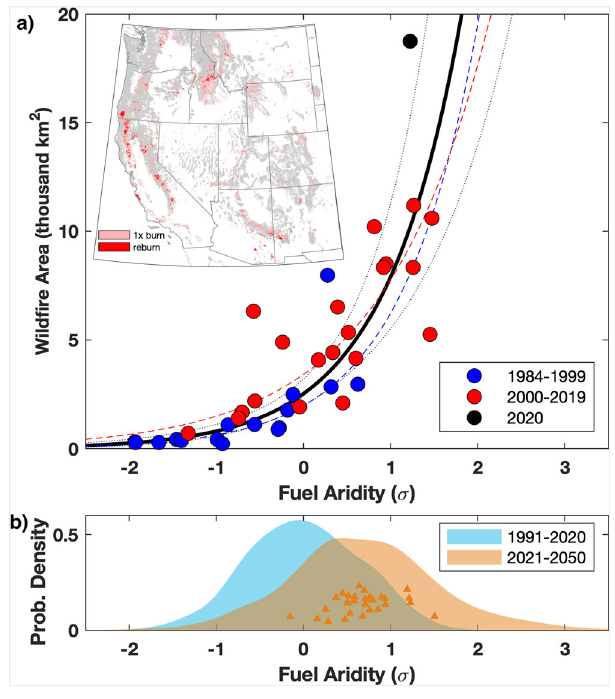
Fig. 1 Nonlinear climate – fi re relationships in western US forests. a Interannual relationship between fuel aridity ( F ) over forested lands vs. annual forest- fi re area for the western US. Curves represent regression for the period 1984 – 2020 (black, dotted shows 95th percentile con fi dence interval), 1984 – 1999 (dashed blue), and 2000 – 2020 (dashed red). Inset map shows forested land burned once (pink) and more than once (red) during 1984 – 2020. Forested land not burned during 1984 – 2020 is shown in gray. b Probability distribution of F pooled from 30 climate models for 1991 – 2020 (teal) and 2021 – 2050 (orange, triangles show the change in mean F for each